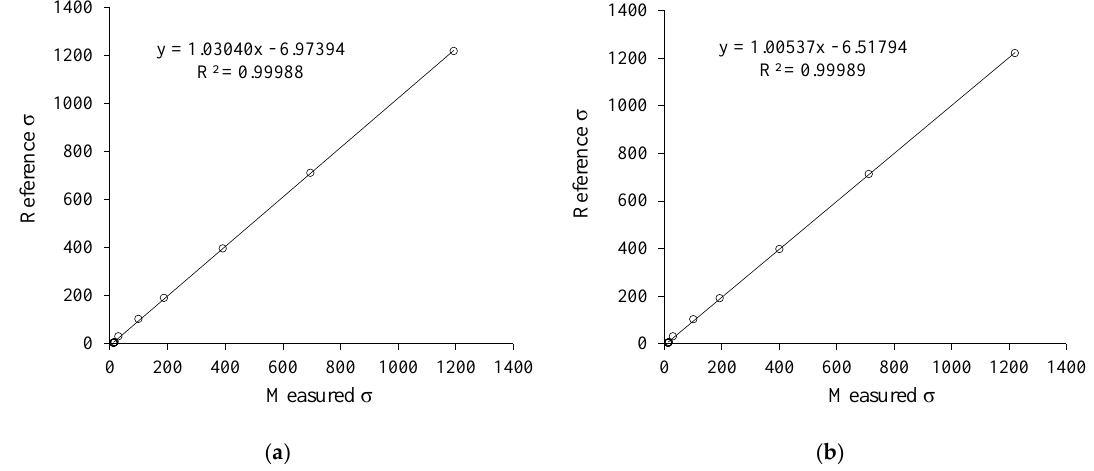
y = 1.03040x - 6.97394 R² = 0.99988